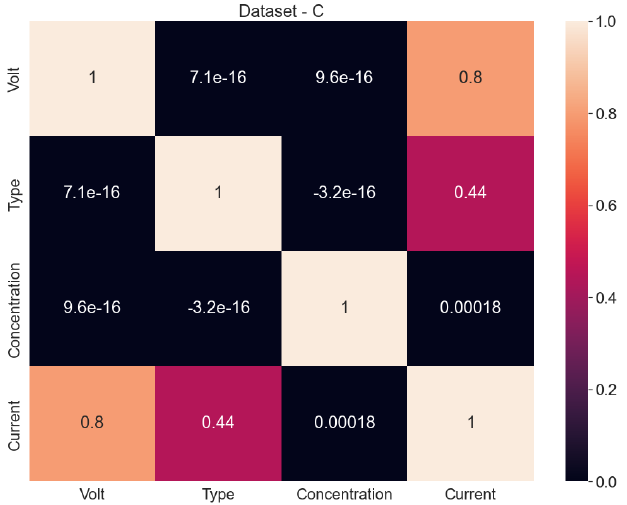
Figure 7. Correlation matrix of Dataset